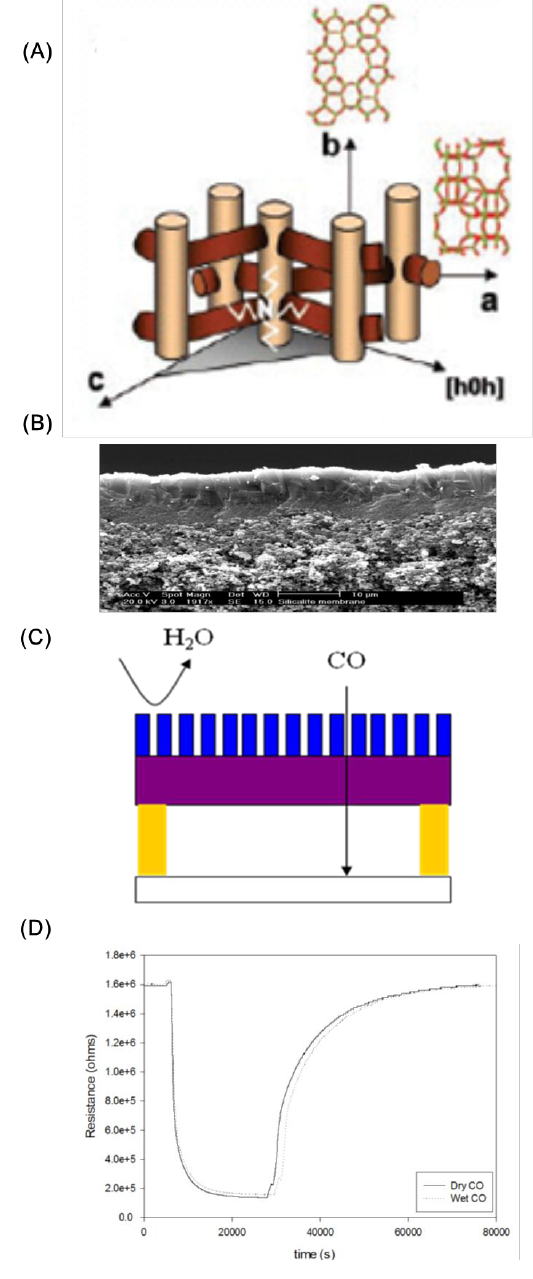
Figure 6. Strategy for rejection of water with a hydrophobic silicalite zeolite filter. ( A ) Channel system of silicalite; ( B ) SEM of zeolite layer on alumina; ( C ) zeolite layer spatially separated from the titania sensor; ( D ) response of the titania sensor with dry and wet CO, 600 °C (adapted from Reference